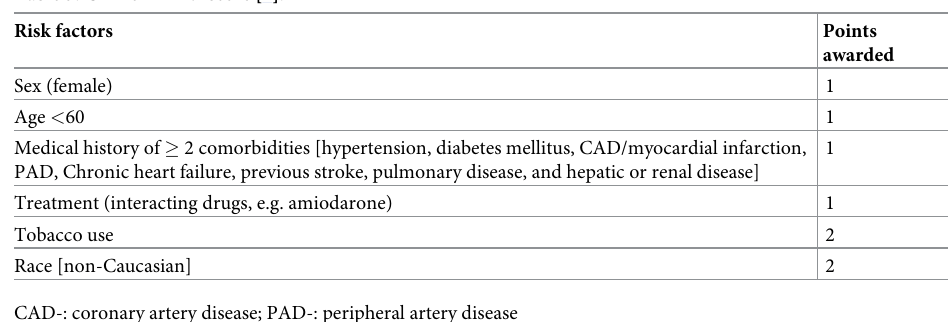
Table 3. SAMe-TT2R2 score [2].